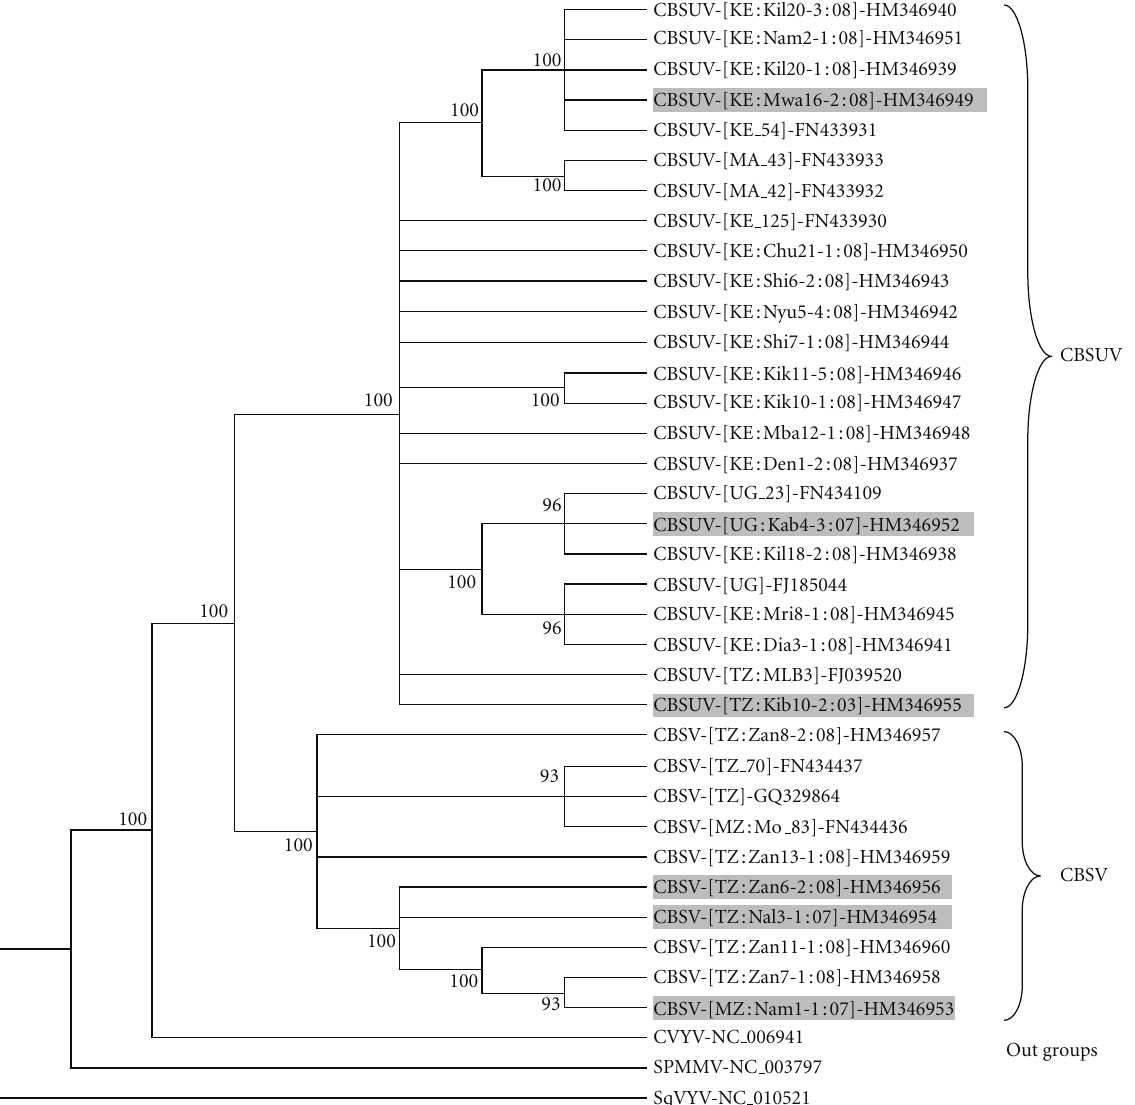
Figure 4: The most parsimonious tree showing the relationship between the two cassava brown streak viruses based on coat protein gene amino acid sequences. The isolates for which symptom diversity was studied are shaded in